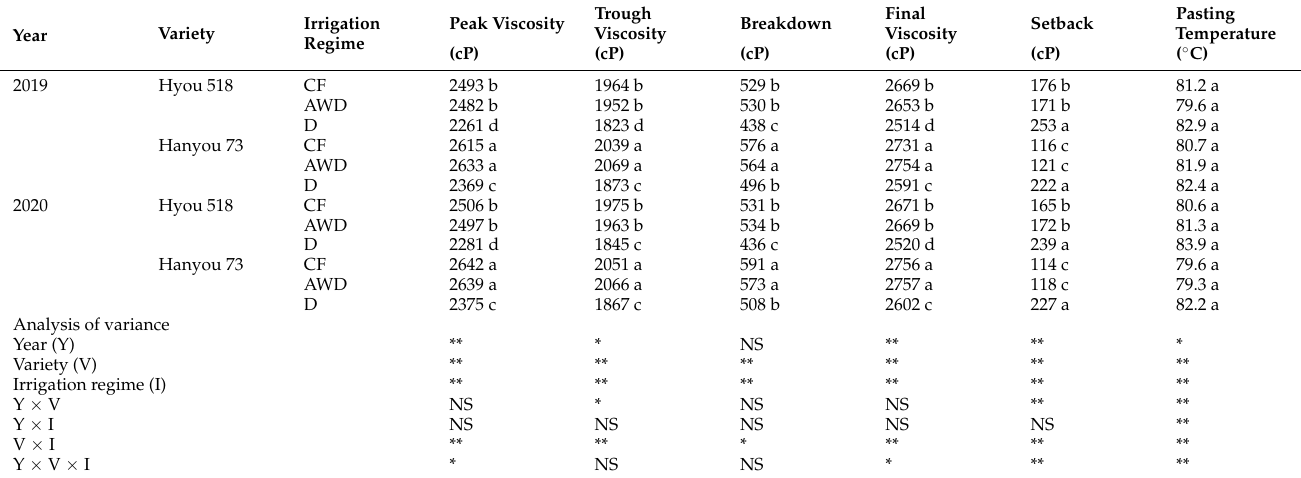
Table 4. Starch viscosity characters under various irrigation